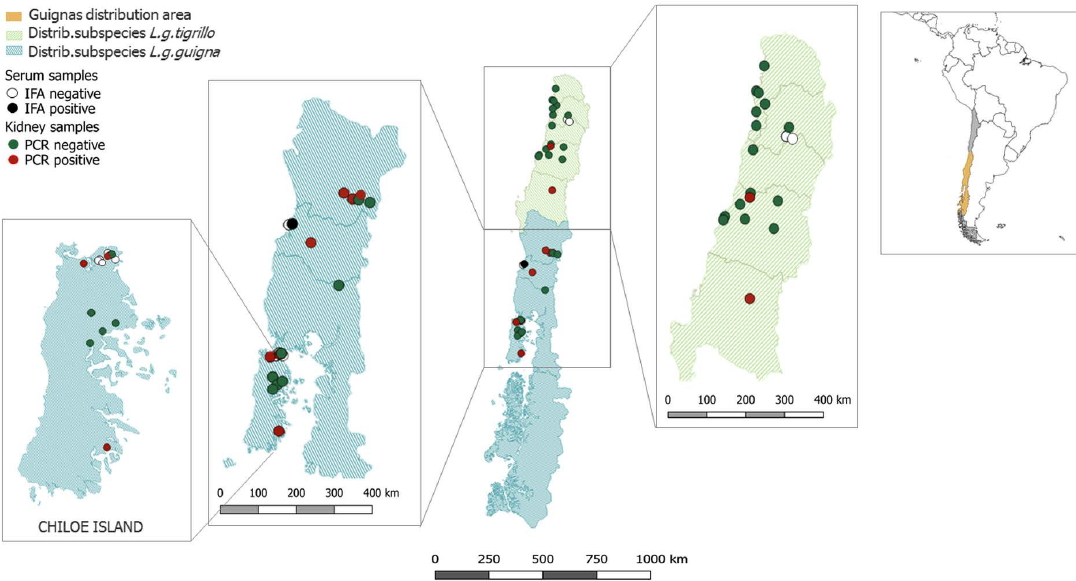
Figure 1. Sampling area of guignas used for PCR and serological analysis. Individual kidney samples of guignas are shown as green (PCR-negative) or red (PCR-positive), whereas serum samples are shown as white (IFA-negative) or black (IFA-positive)